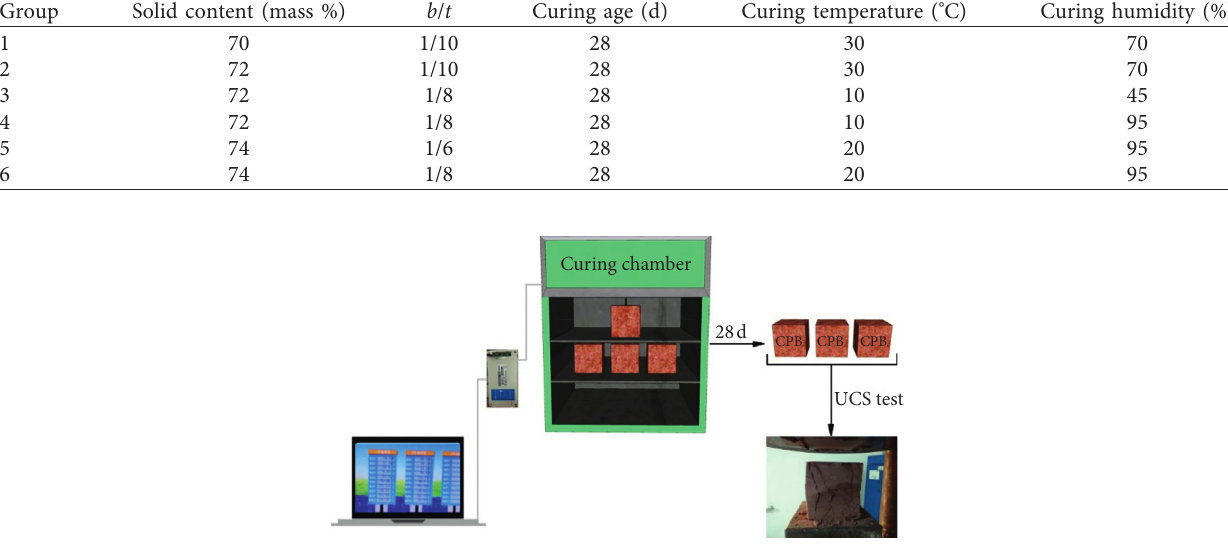
Figure 3: Experimental procedure.